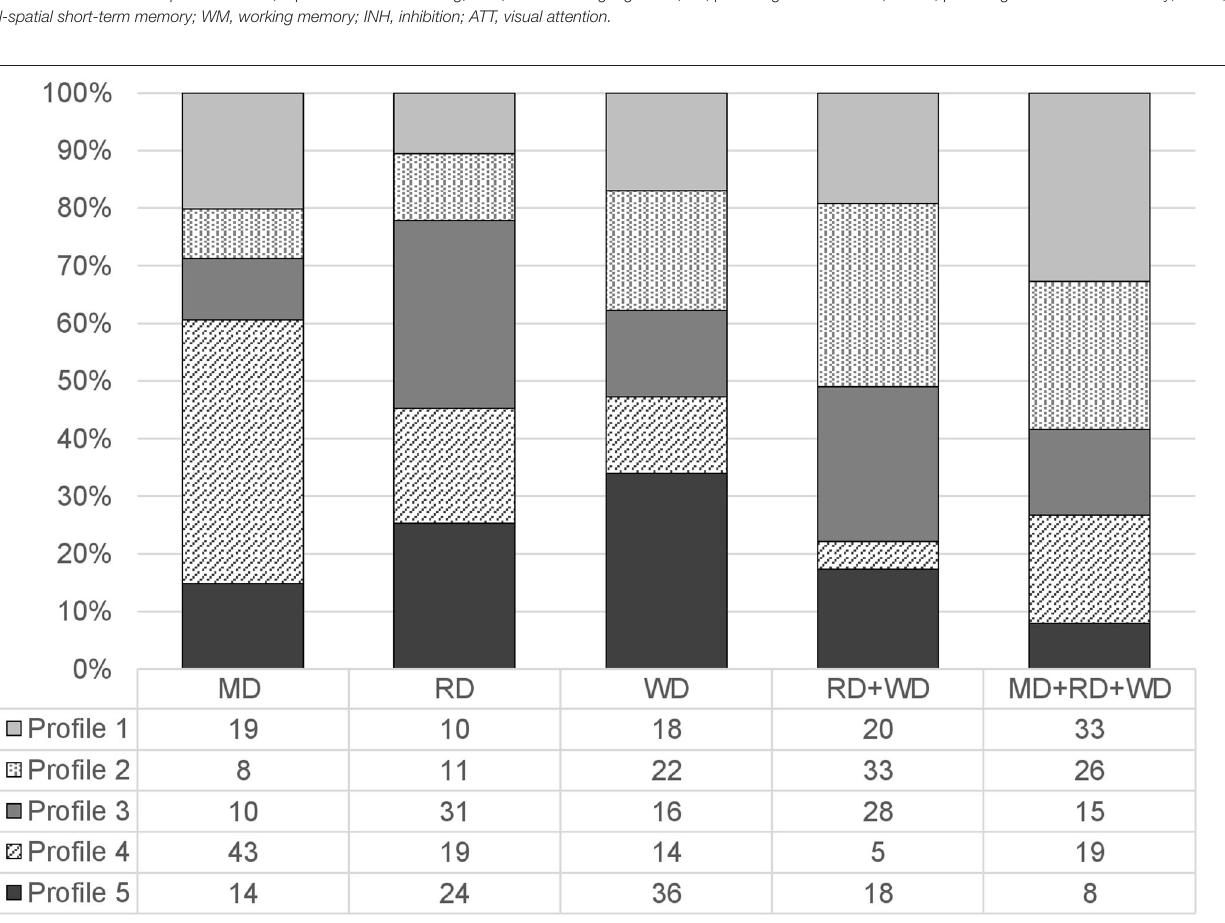
FIGURE 2 | Distribution of the latent cognitive profiles across the LD subtypes. MD, Mathematical Disorder; RD, Reading Disorder; WD, Writing